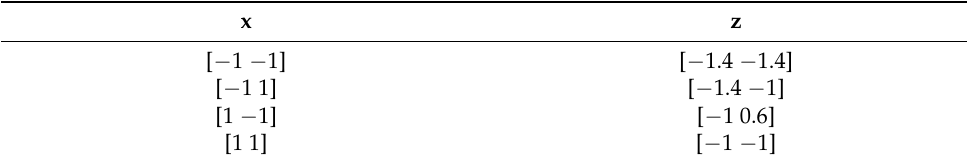
Figure 2. Branch metric of the trellis for the channel interfered signal. Table 1. The values z corresponding to the values x